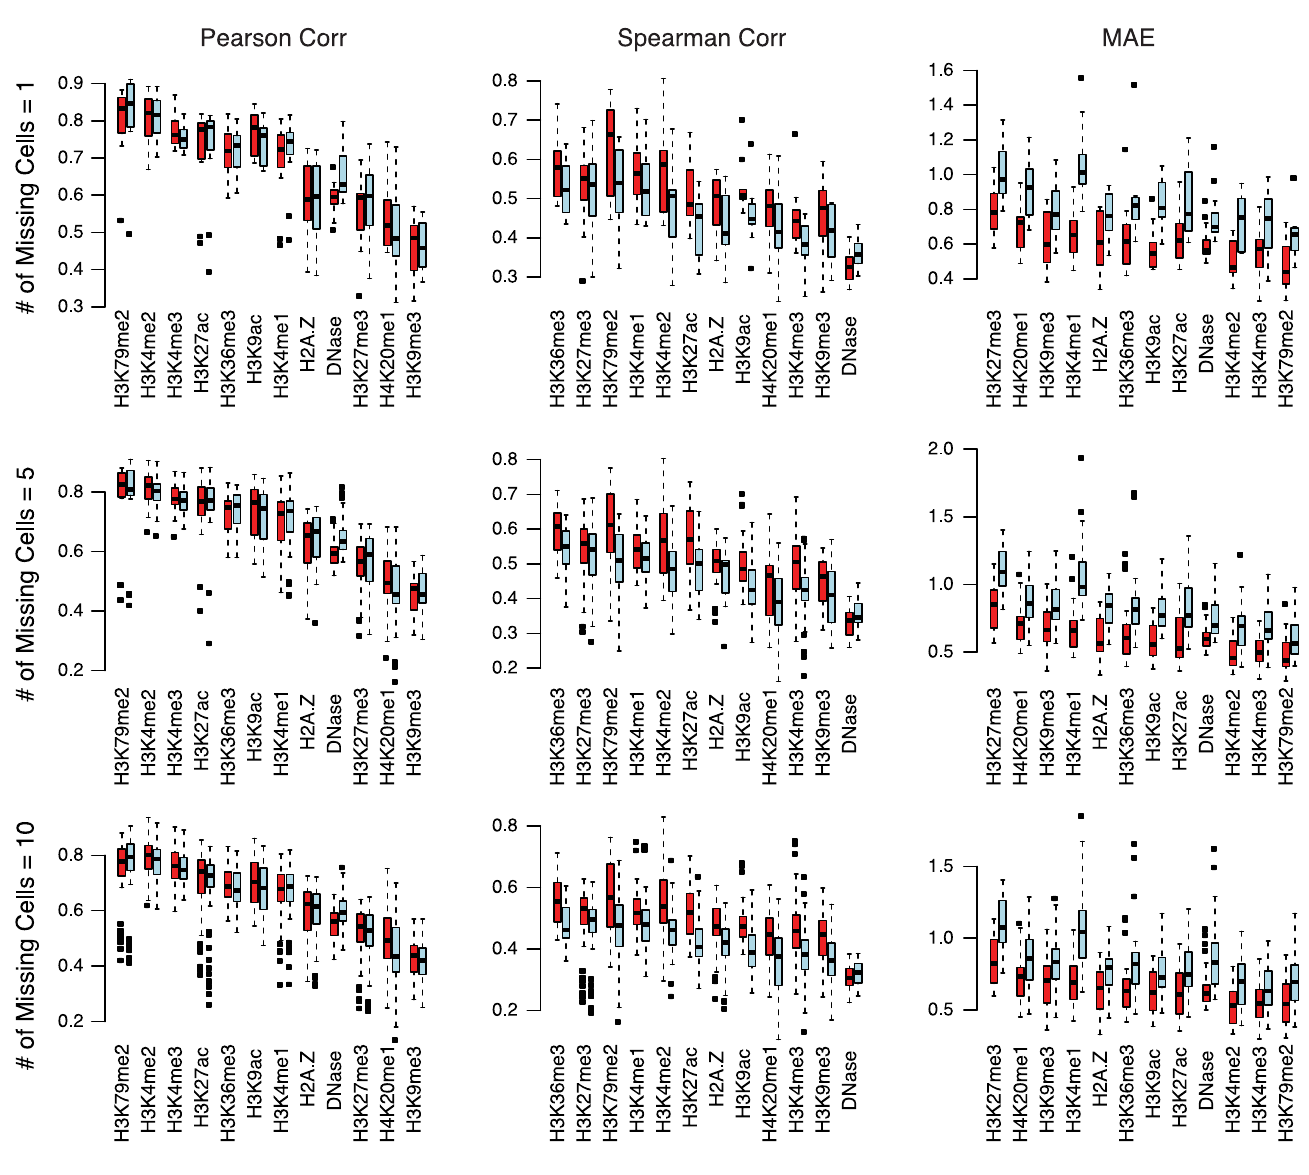
Fig 4. Comparison of accuracy of imputed chromatin marks between IDEAS and ChromImpute. Three accuracy measures are calculated: Pearson correlation, Spearman correlation, and mean absolute error (MAE) between IDEAS (red boxes) and true signals, and between ChromImpute (blue boxes) and true signals. The results shown are calculated from 8 missing marks per missing cell. Results for 10 and 11 missing marks are similar and shown in S1 Fig and S2 Fig,